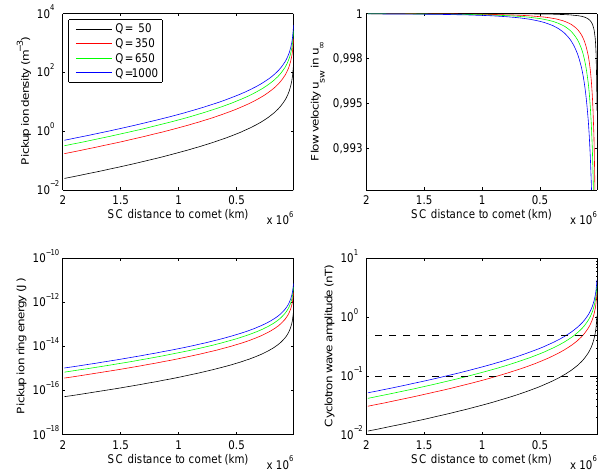
Fig. 2. Top left: The ion pick-up density along the orbit of Rosetta for various outgassing rates 50 (black), Fig. 2. Top left: the ion pickup density along the orbit of Rosetta for 350(red),650(green)and1000(blue) 10 23 s (cid:0) 1 . Topright: Themass-loadedflowvelocity u sw inunitsof u 1 . various outgassing rates 50 (black), 350 (red), 650 (green) and 1000 Bottom left: The energy in the pick-up ring distribution. Bottom right: The amplitude of the ion cyclotron (blue) 10 23 s − 1 . Top right: the mass-loaded flow velocity u sw in wavesassumingfullscatteringoftheringdistribution. Thedashedhorizontallineat0.1nTindicatesthesolar units of u ∞ . Bottom left: the energy in the pickup ring distribution. windnoiselevel. Theupperdashedlinemarksthe0.5nTamplitude. Bottom right: the amplitude of the ion cyclotron waves assuming full scattering of the ring distribution. The dashed horizontal line at 0.1nT indicates the solar wind noise level. The upper dashed line marks the 0.5nT